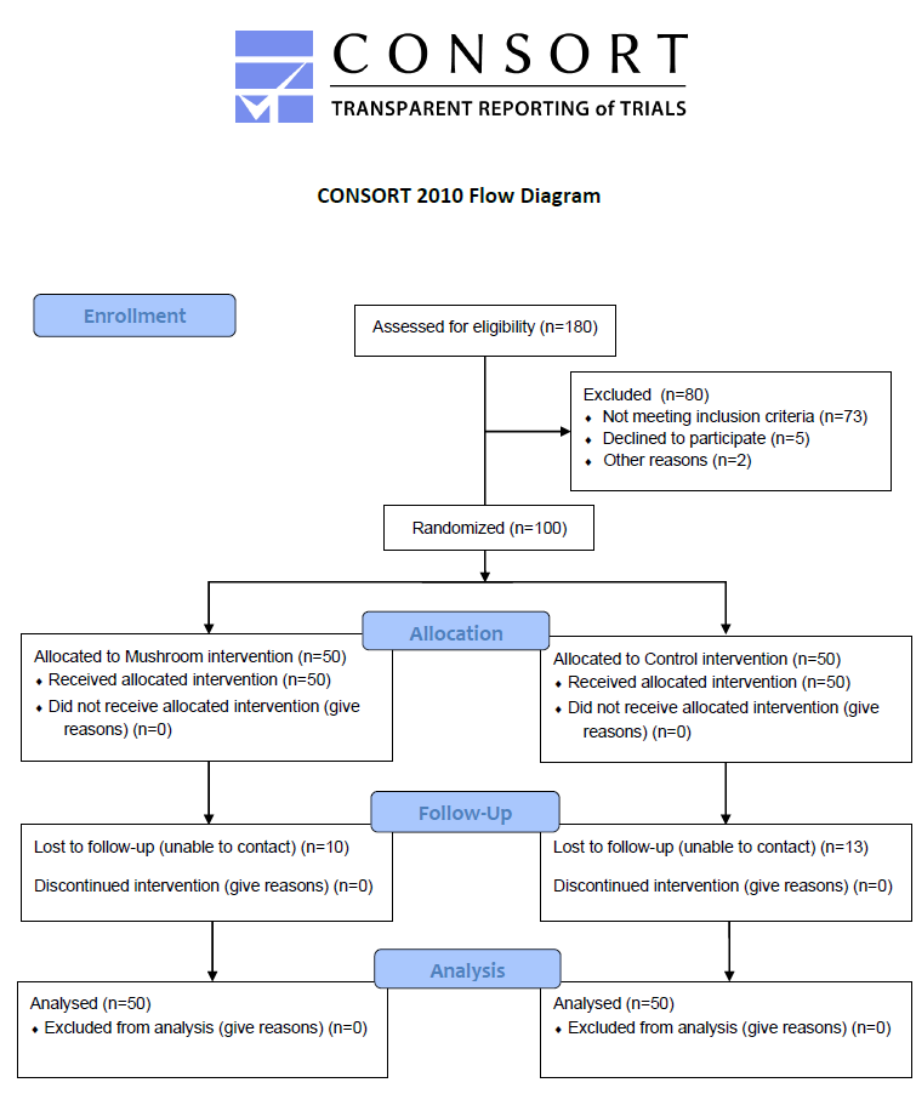
Figure 1. Study Flow diagram .